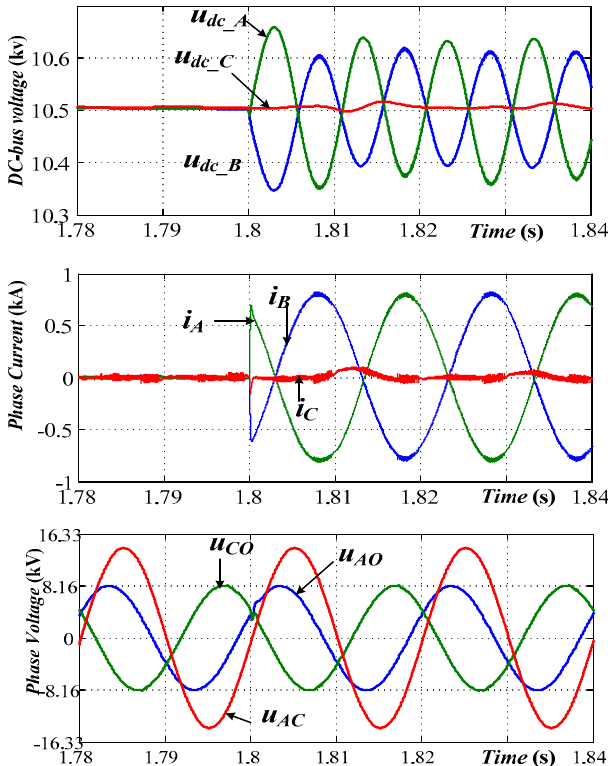
Figure 9. Simulation results at the individual phase full-power operation state.